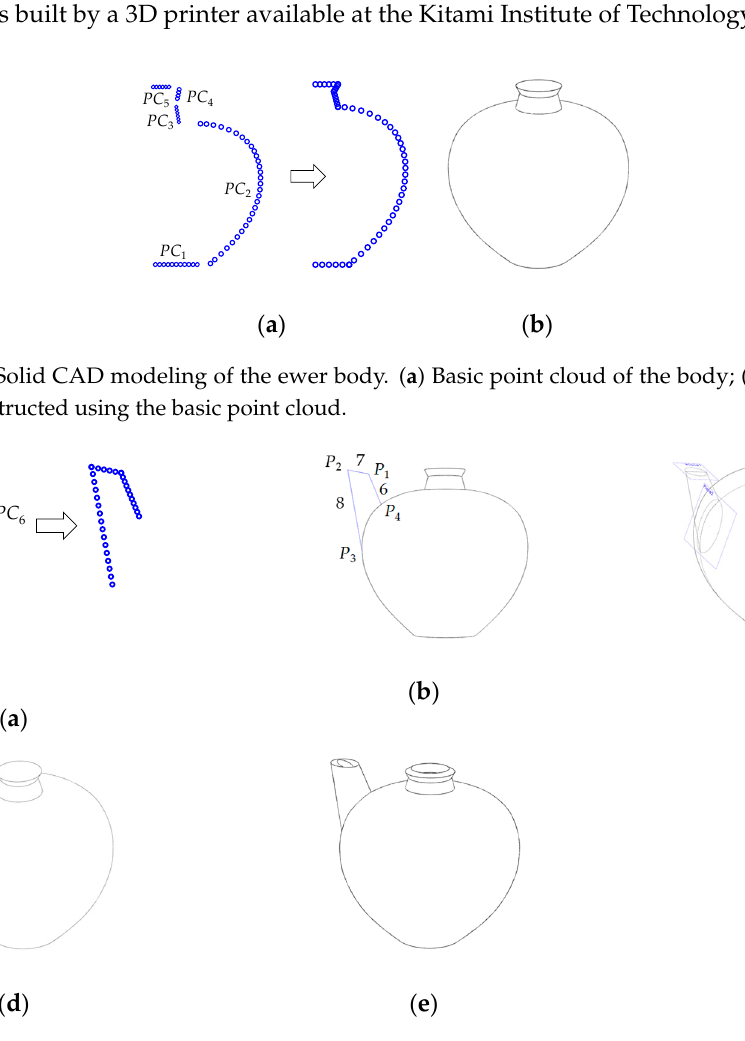
Figure 18. Solid CAD modeling of the ewer spout. ( a ) Basic point cloud of the spout; ( b ) point cloud of the spout injected into the solid CAD model; ( c ) reference planes and ellipses to construct spout; ( d ) result of spout construction; ( e ) a solid CAD model with hollow inside.